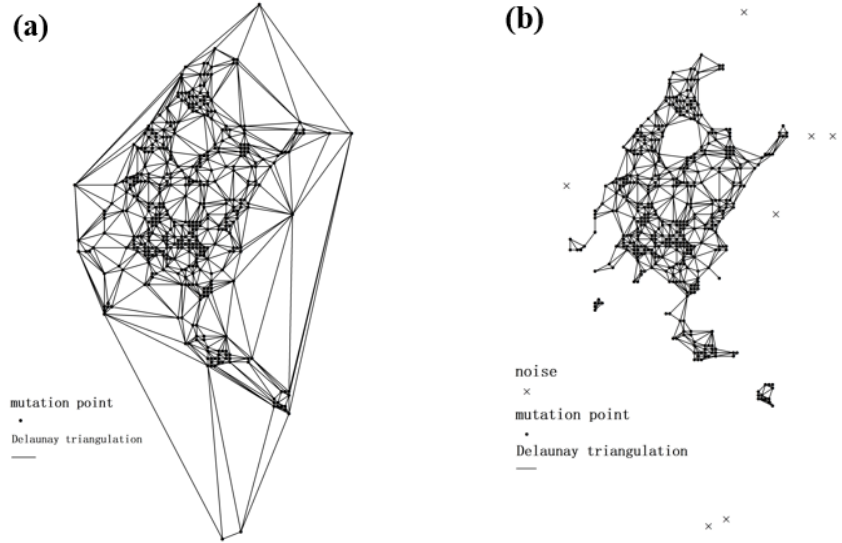
Figure 9. Spatial proximity relationships between mutation points: ( a ) construction of DT; ( b ) global and local edge‑length constraints.